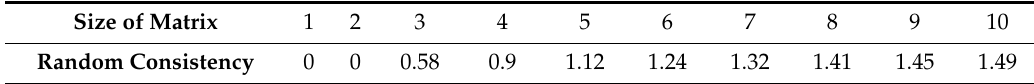
Table 3. Average random consistency (RI) [38,40].